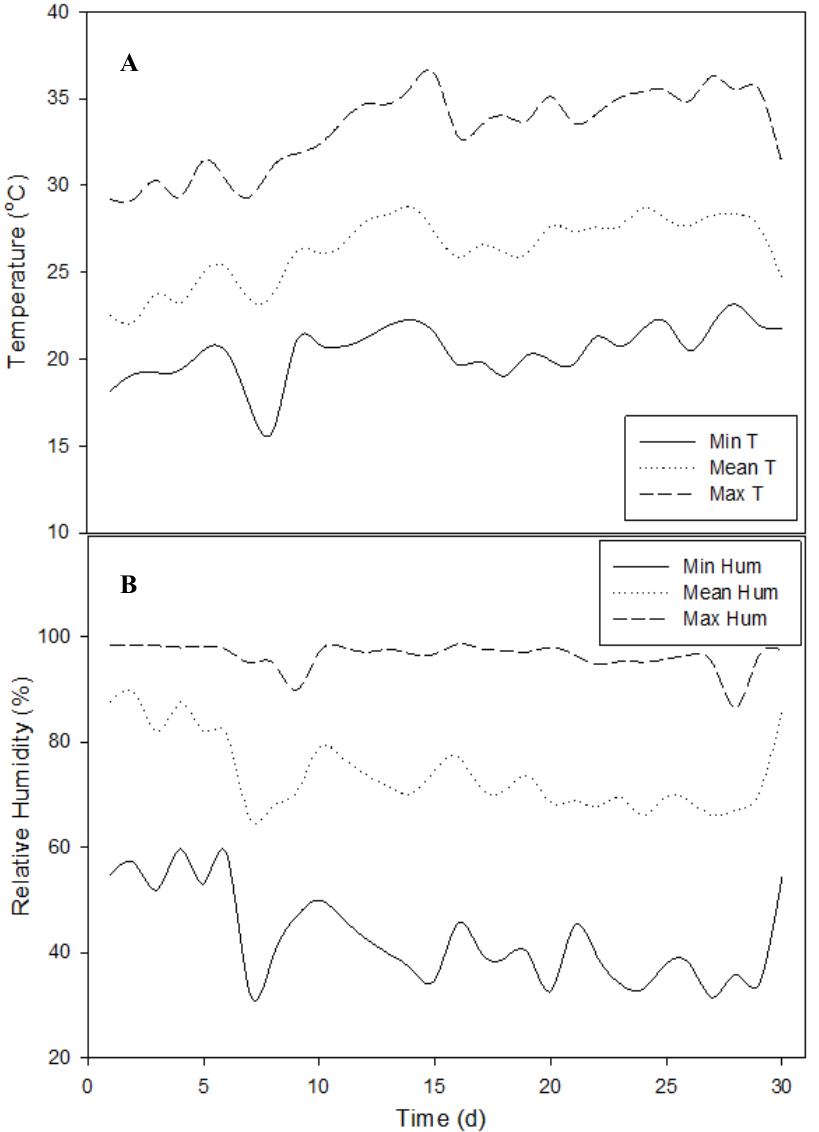
Figure 3. Minimum (min), average (mean) and maximum (max) daily ( A ) air temperature; and ( B ) relatively humidity for the month of June 2010 for the study site. Wastewater